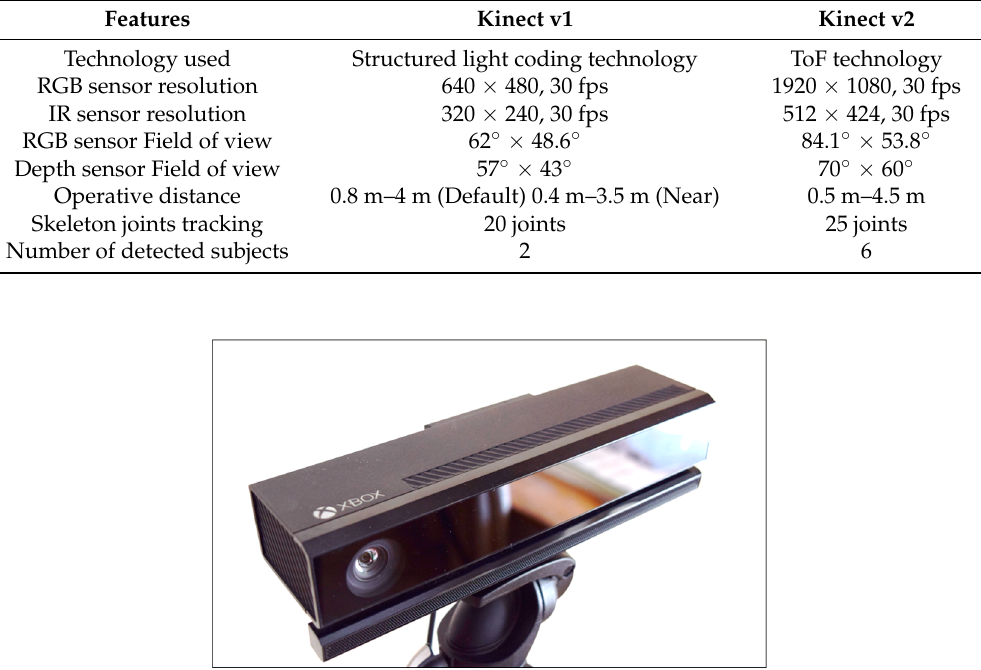
Table 1. A comparison between the Microsoft Kinect v1 and v2.